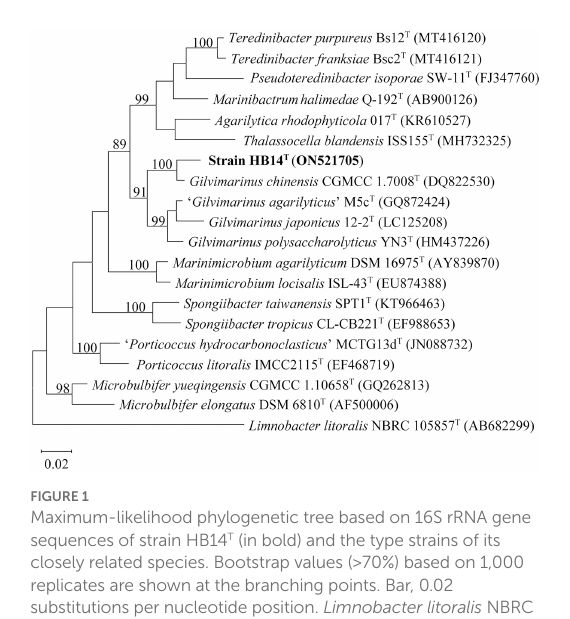
FIGURE 1 Maximum-likelihood phylogenetic tree based on 16S rRNA gene sequences of strain HB14 T (in bold) and the type strains of its closely related species. Bootstrap values (>70%) based on 1,000 replicates are shown at the branching points. Bar, 0.02 substitutions per nucleotide position. Limnobacter litoralis NBRC 105857 T was used as the